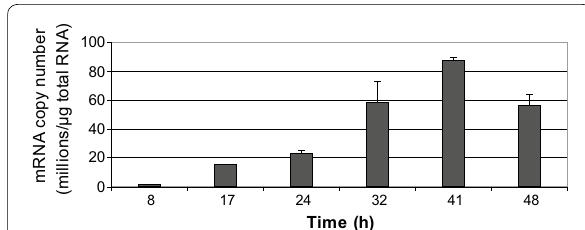
Fig. 4 The result of quantitative real‑time reverse transcription PCR analysis of phaG gene. Samples were taken during cultivation of P. putida KT2440 relA / spoT mutant in bioreactor